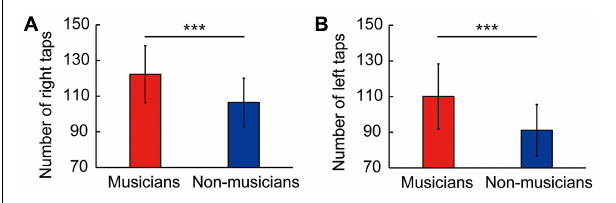
FIGURE 1 | Skillful tapping in musicians. Compared to non-musicians, musicians showed enhanced performances in right tapping speed (A) and left tapping speed (B) . Parameters are indicated as the mean ( SD ). *** P < 0.001 vs. non-musicians. SD , standard deviation.